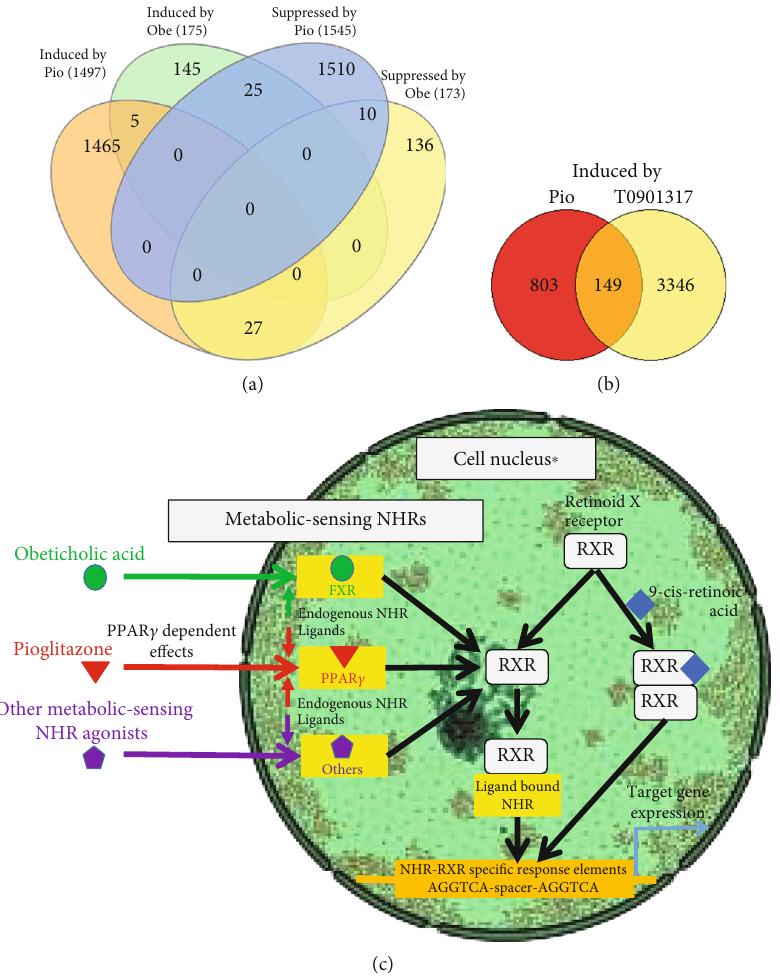
Figure 7: Distinct e ff ects of Pio vs other NHR agonists. (a, b) Venn diagrams depicting (a) distinct e ff ects of PIO (reported here) versus obeticholic acid (Obe, reported in [45]) on the hepatic transcriptome in mice and (b) PIO (reported here) versus the LXR α agonist T0901317 (reported in [35]) on the liver RXR cistrome. (c) Hypothetical model illustrating how di ff erent NHR-binding drugs might exert unique e ff ects on transcriptional regulation by competing for RXR-binding, with di ff erent NHR-RXR heterodimers displaying distinct a ffi nities for speci fi c NHR-RXR DNA response elements based on spacer length and other factors (e.g., RXR-ligand binding by 9-cis- retinoic acid). RXR homo-dimerization also a ff ects transcription. ∗ The cell nucleus illustration is adapted from vectors from